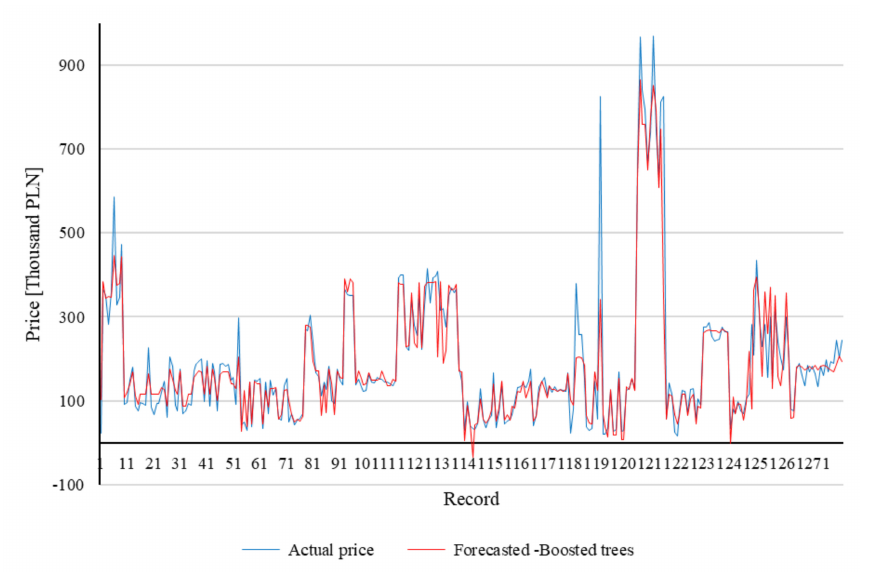
Figure 6. Results of forecasting the price of electric cars using boosted tree model.